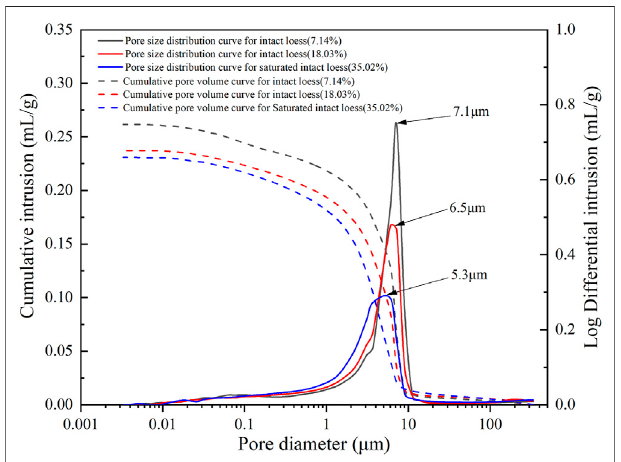
FIGURE 13 | Pore size distribution curves and cumulative pore volume curves of intact loess at different initial water contents after compression.